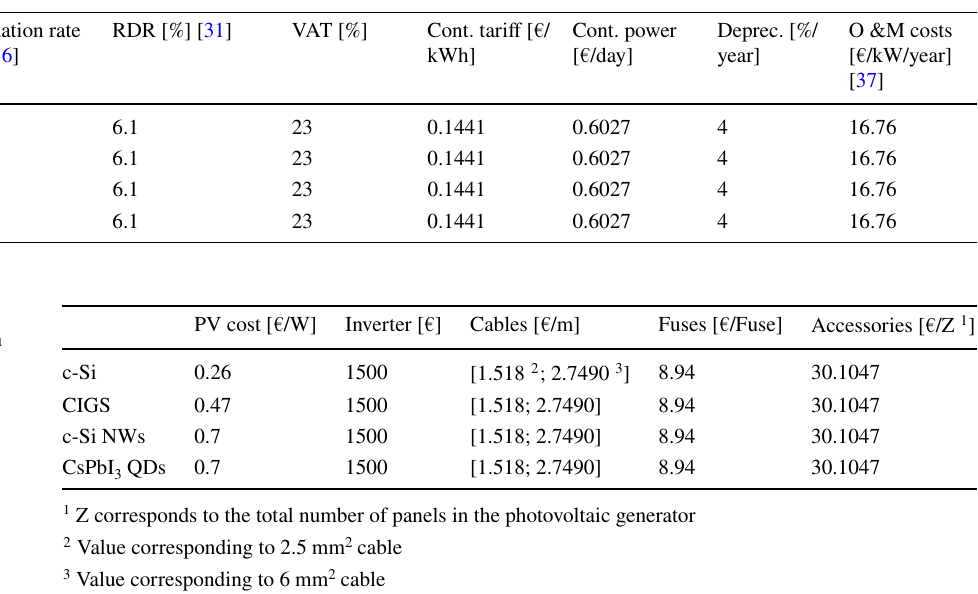
Table 1 Input parameters for cash flow computation